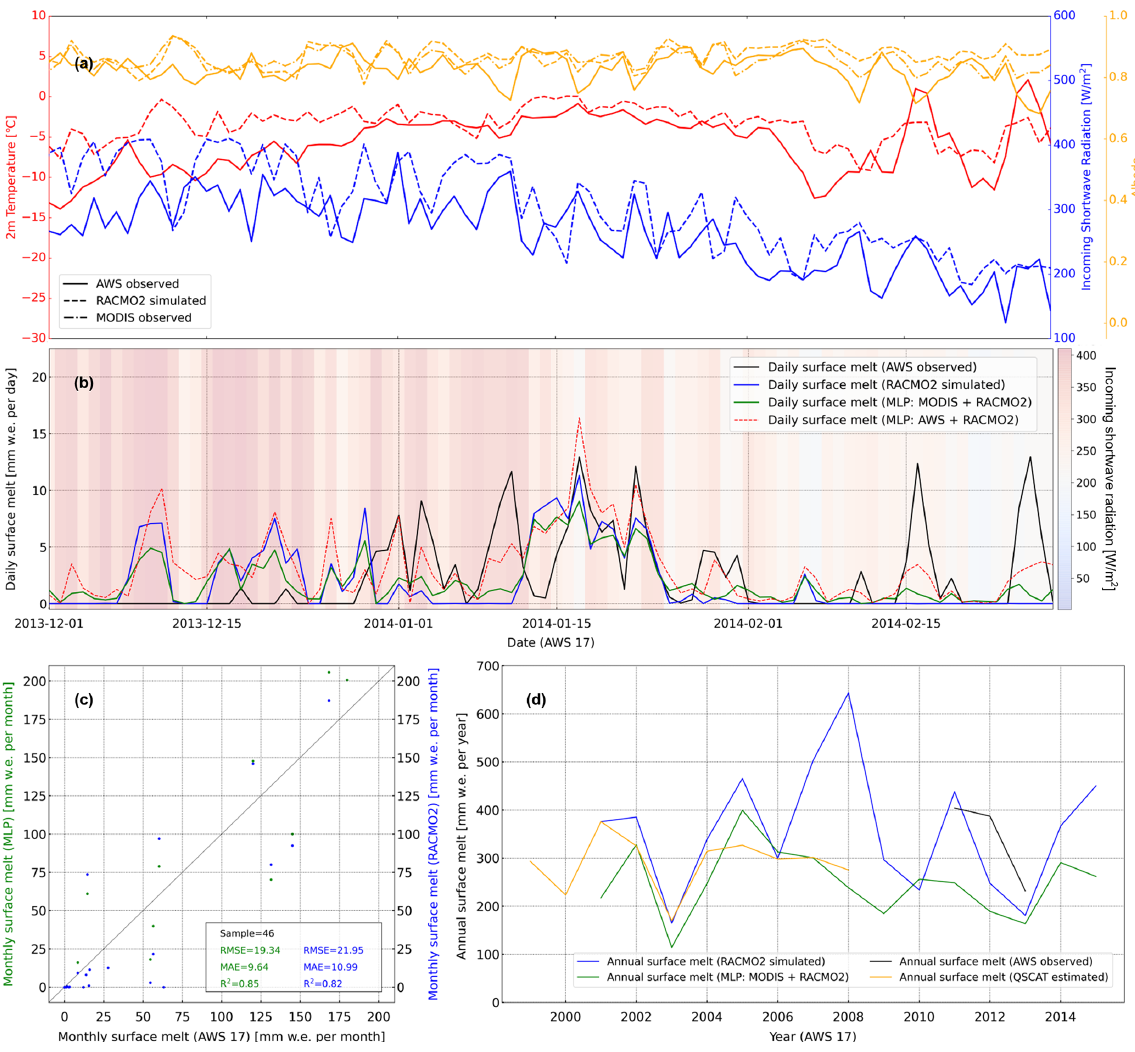
Figure 10. The same as Fig. 9 but for AWS